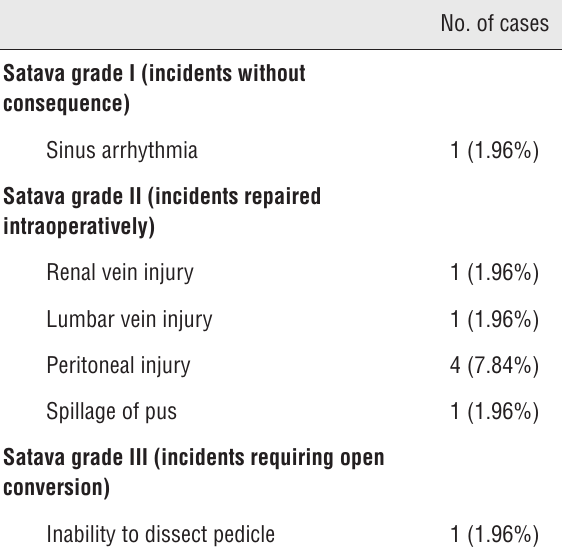
Table 1 - Preoperative and operative characteristics of patients.